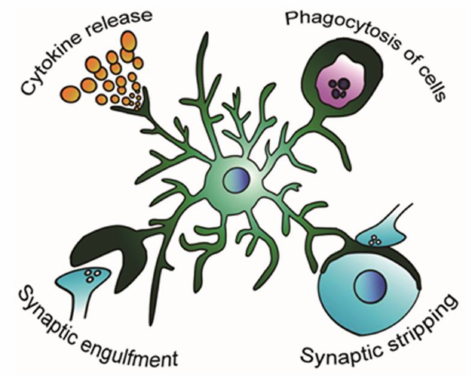
Figure 1. Possible modification of the microglial role in the epileptic brain. Microglia respond to the epileptic environment and change their activity of releasing proinflammatory and anti-inflammatory cytokines [16], phagocytosing apoptotic and living cells [18,19], engulfing synapses [20], and stripping synapses